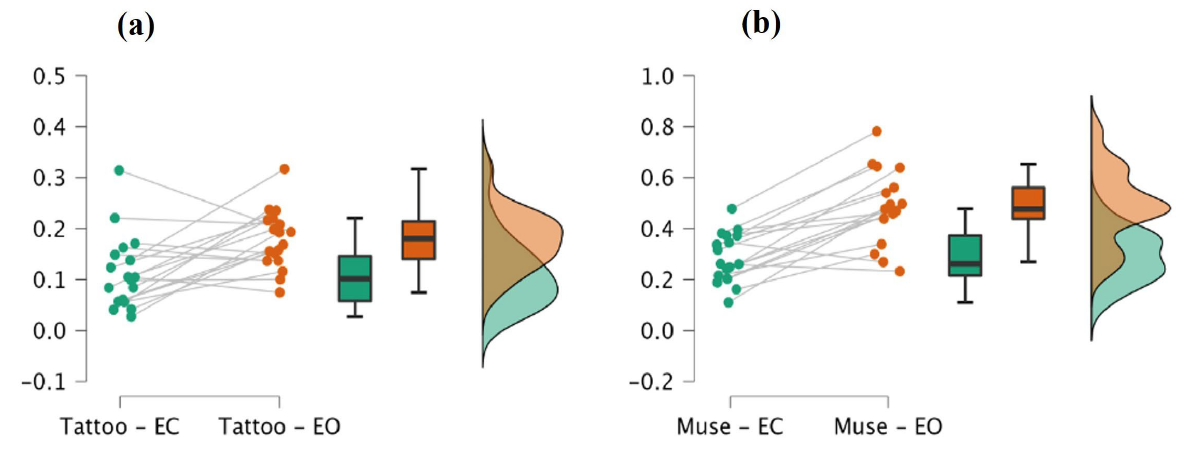
Figure 4. Raincloud plots for tattoo-based EEG system ( a ) and the Muse headset ( b ), with the underlying distributions of the relative power spectral density computed for the alpha frequency band.